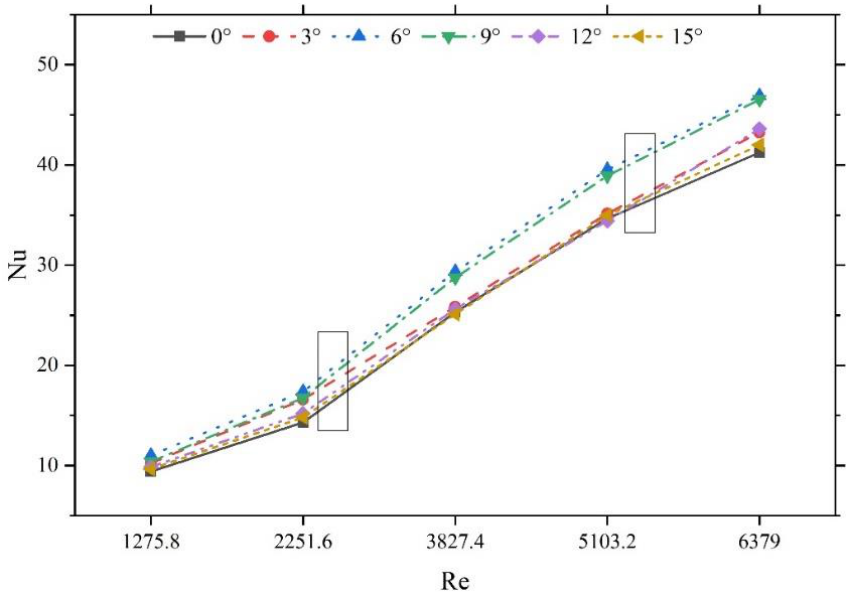
Figure 13. Nusselt numbers of different taper angle models.